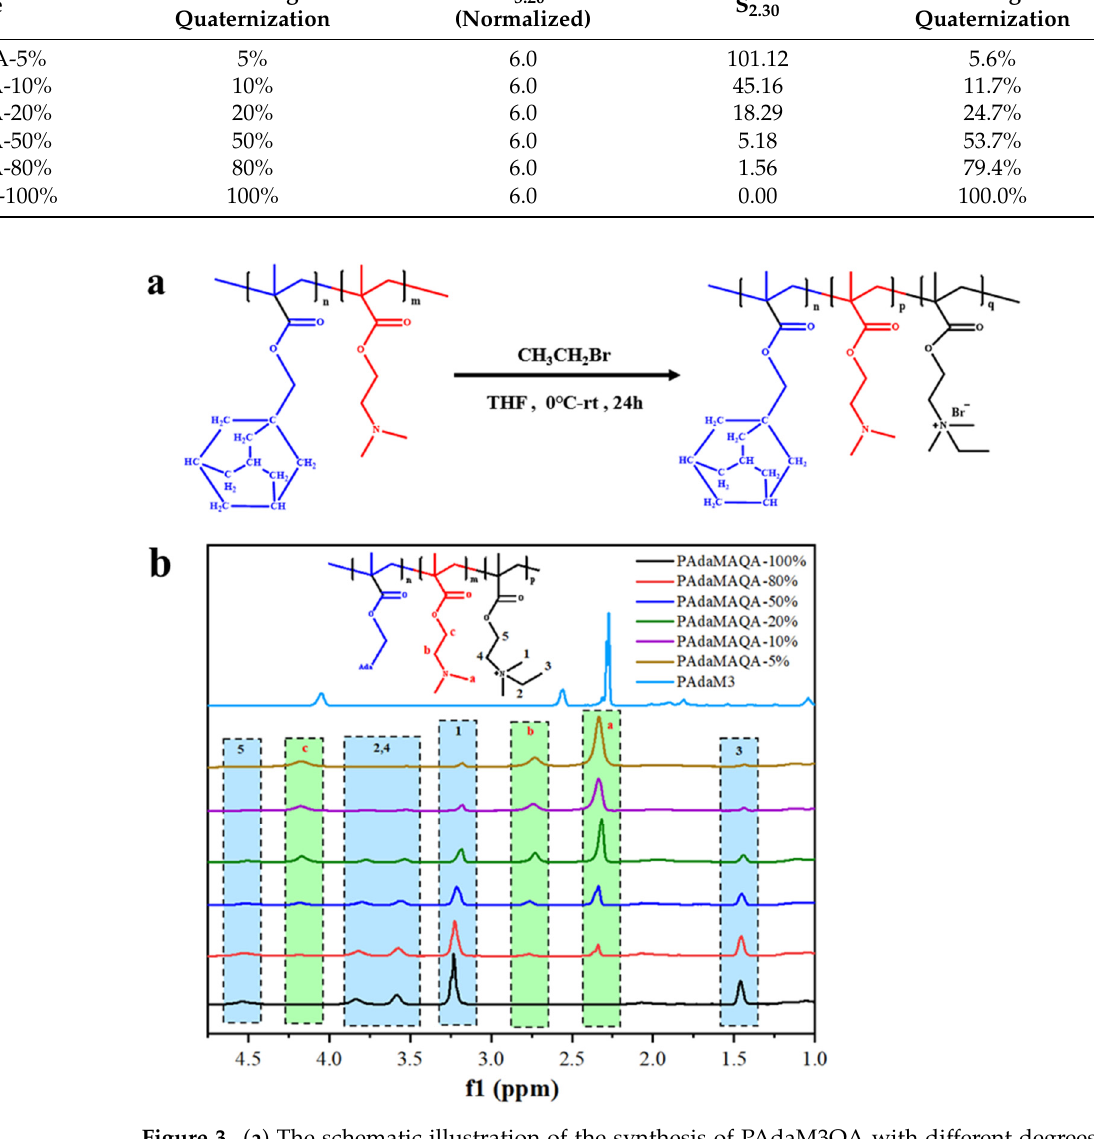
Figure 3. ( a ) The schematic illustration of the synthesis of PAdaM3QA with different degrees